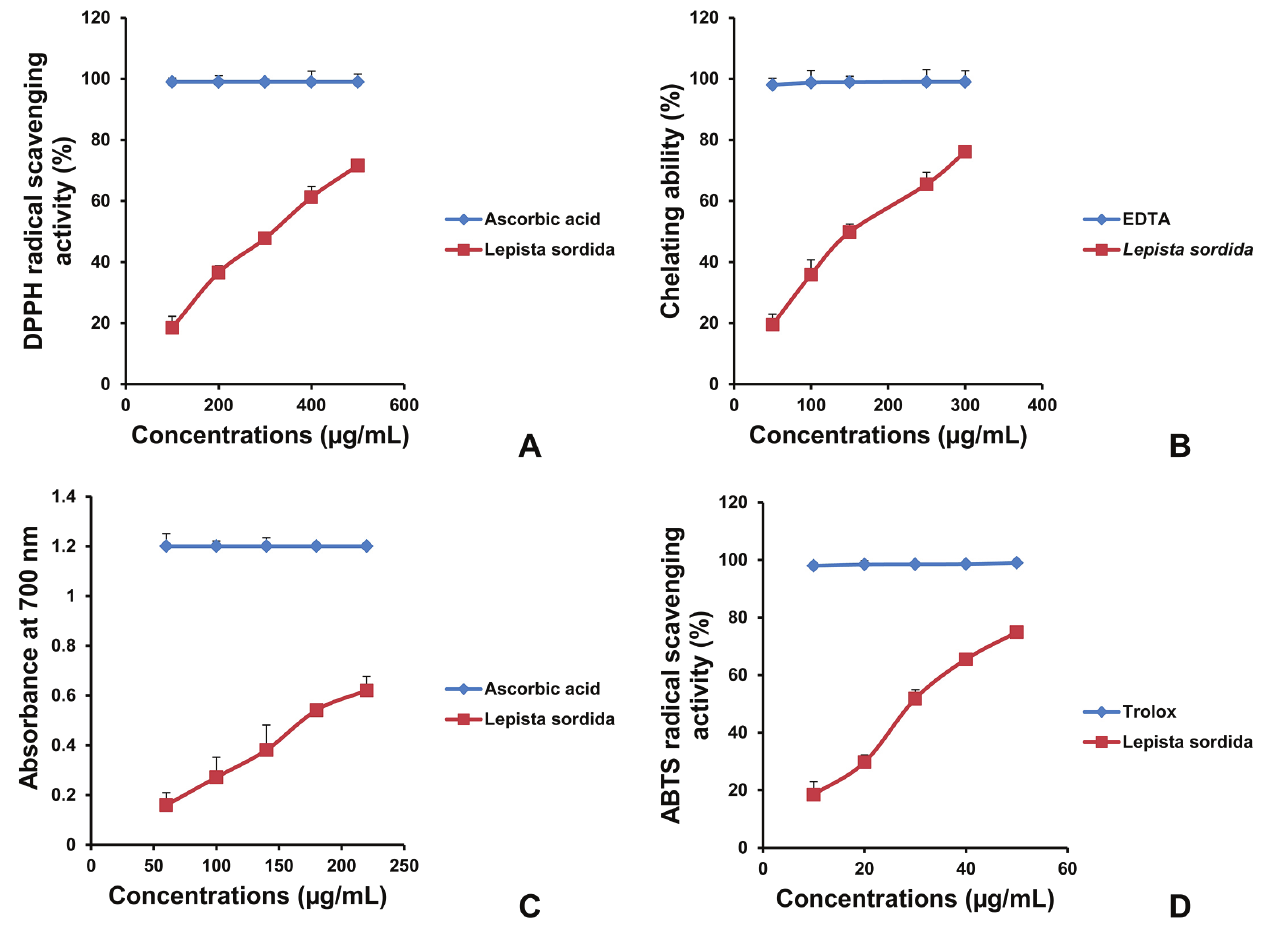
FIGURE 2 - Antioxidant activity of methanolic extract from Lepista sordida A) DPPH radical scavenging activity B) Chelating ability C) Reducing power D) ABTS radical scavenging